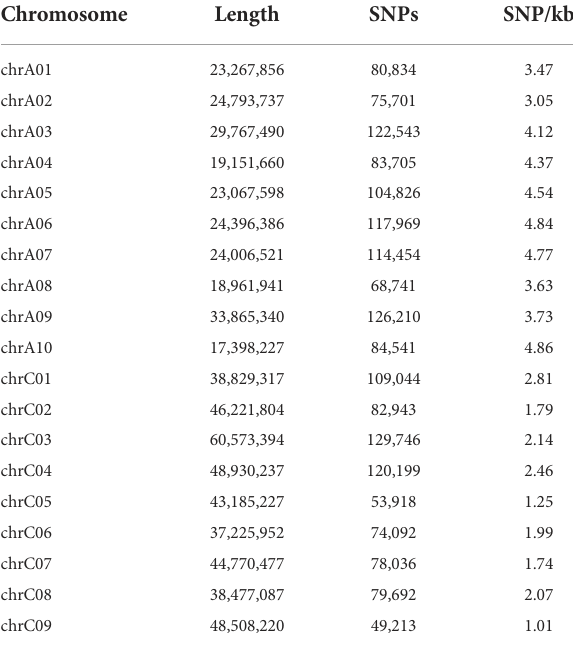
TABLE 2 Statistics of SNP number and density on each chromosome.